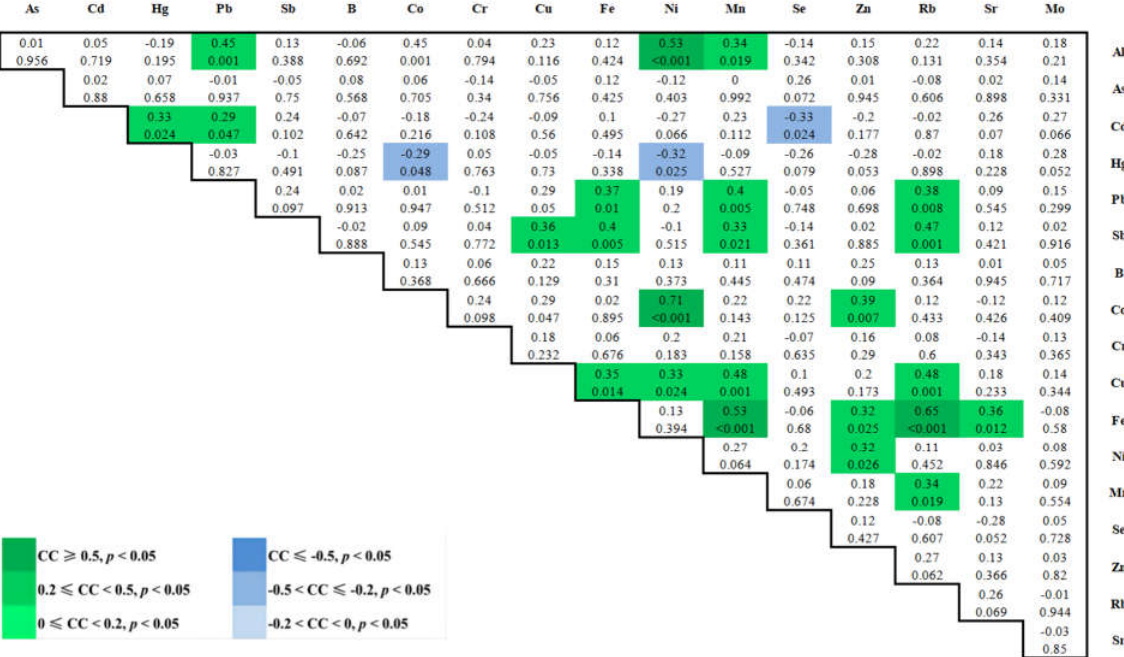
Figure 5. Color map of the Spearman correlations between 18 elements in cord plasma.